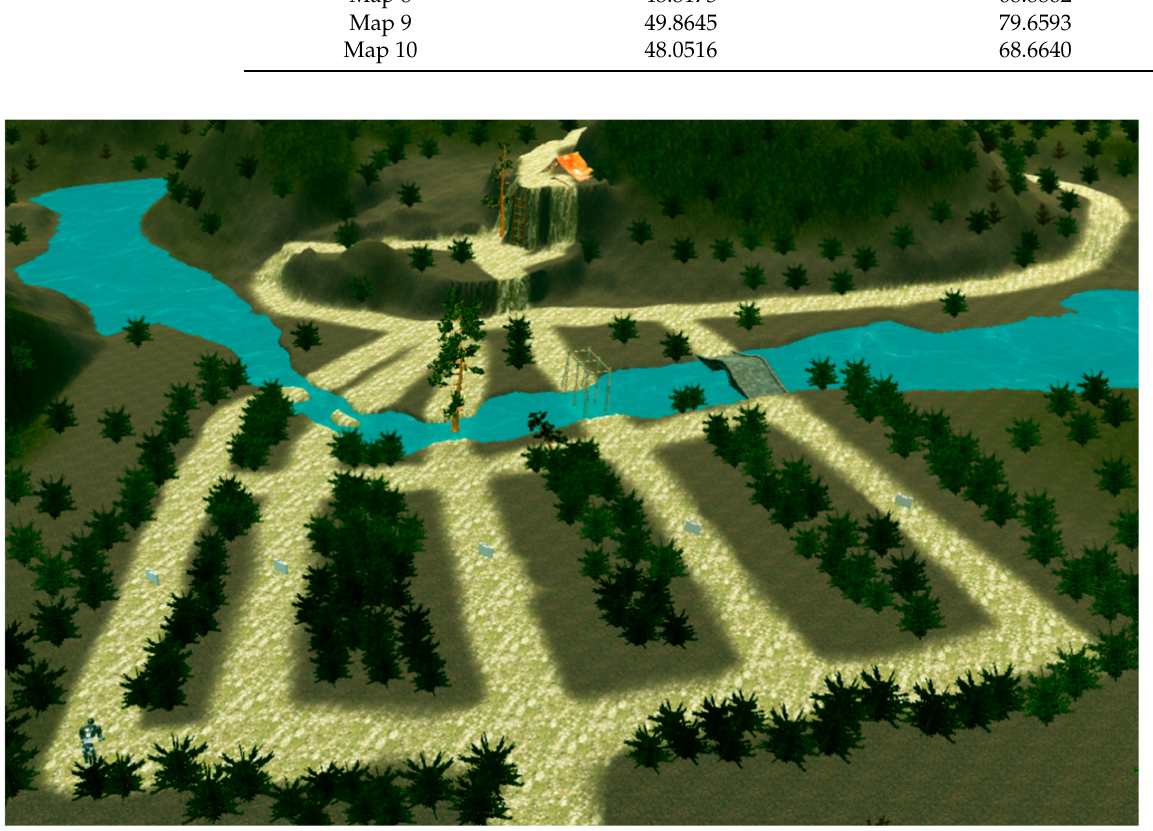
Figure 20. The simulated